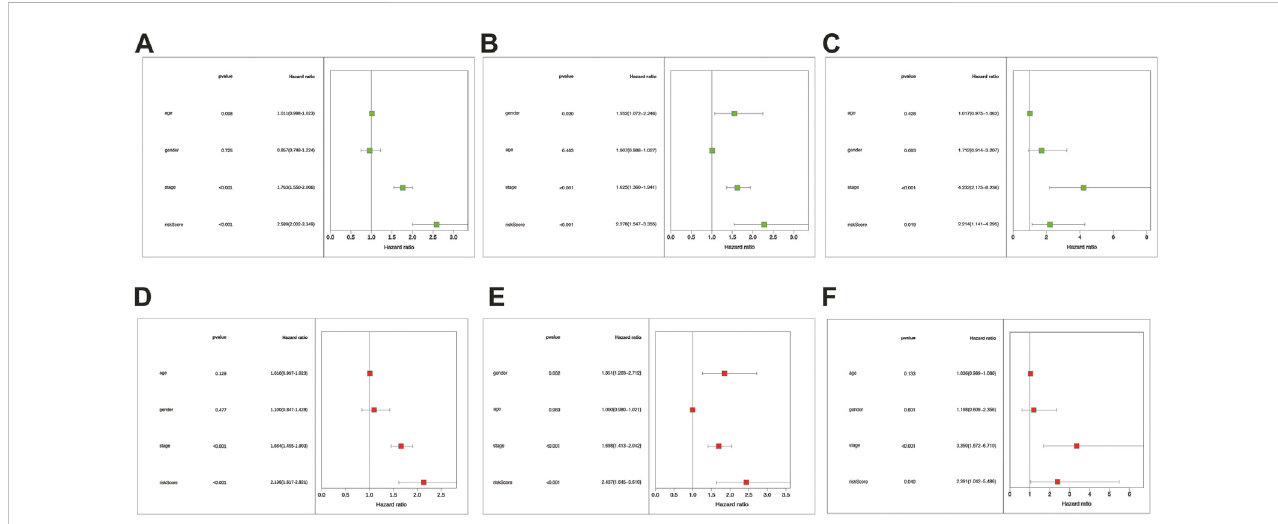
FIGURE 6 The risk score was the independent prognostic factor in LUAD cohorts. Forest maps were made based on the univariate cox analysis results (A – C) . Multivariatecoxanalysisresultswereshowninpictures (D – F) . (A,D) correspondtothemergecohort; (B,E) correspondtotheGSE72094set; (C,F) correspond to the GSE31210 set. p < .05 was considered signi fi cant.